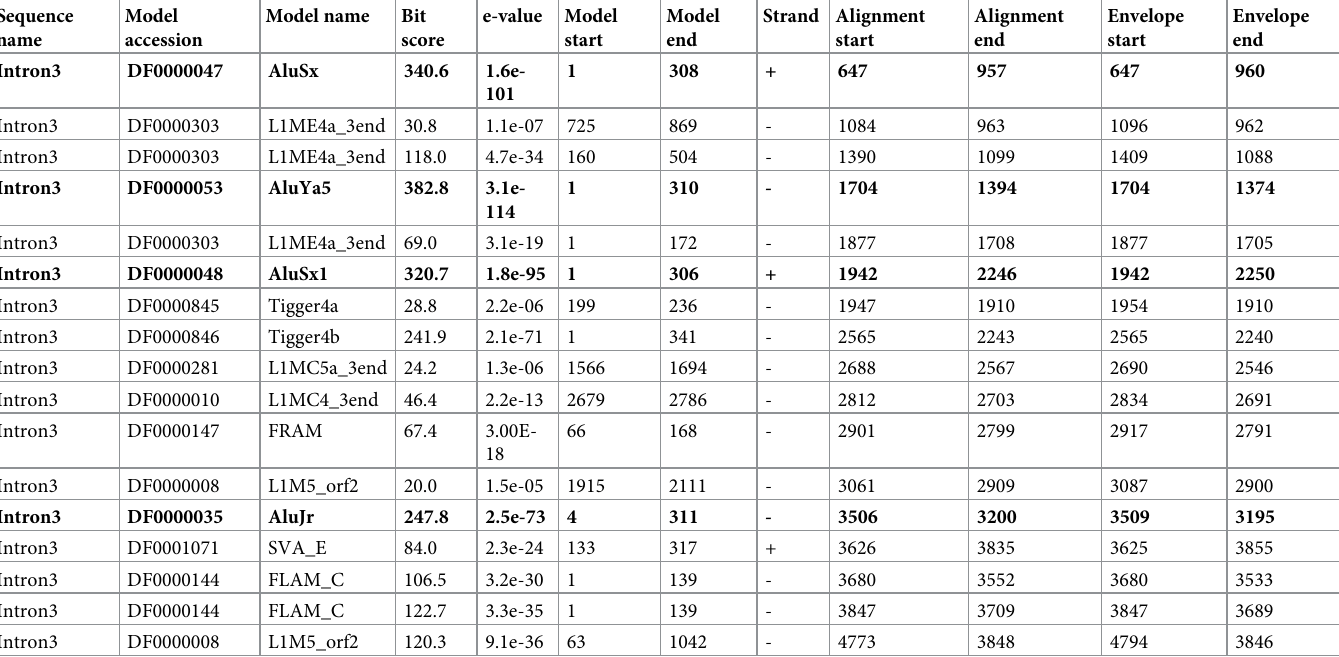
Table 1. Alu elements in the RBMX2 gene.